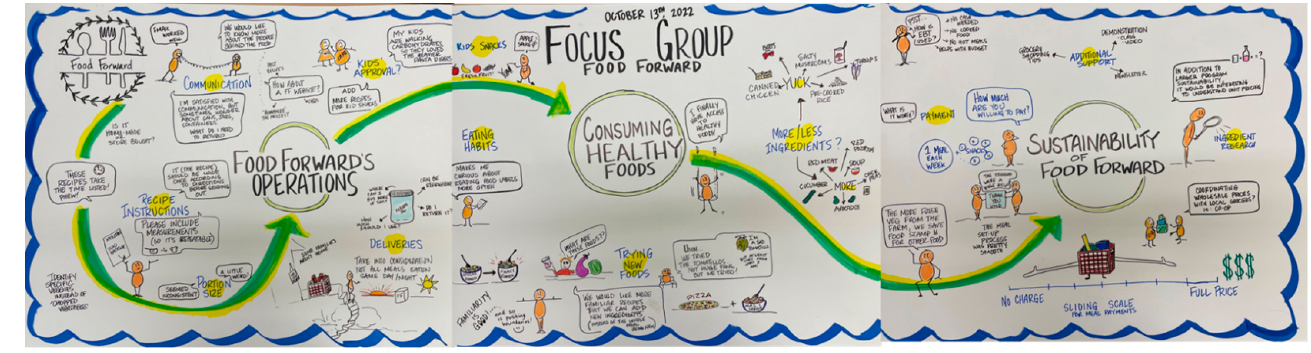
Figure 2. Graphic Recording of Focus Group 2.